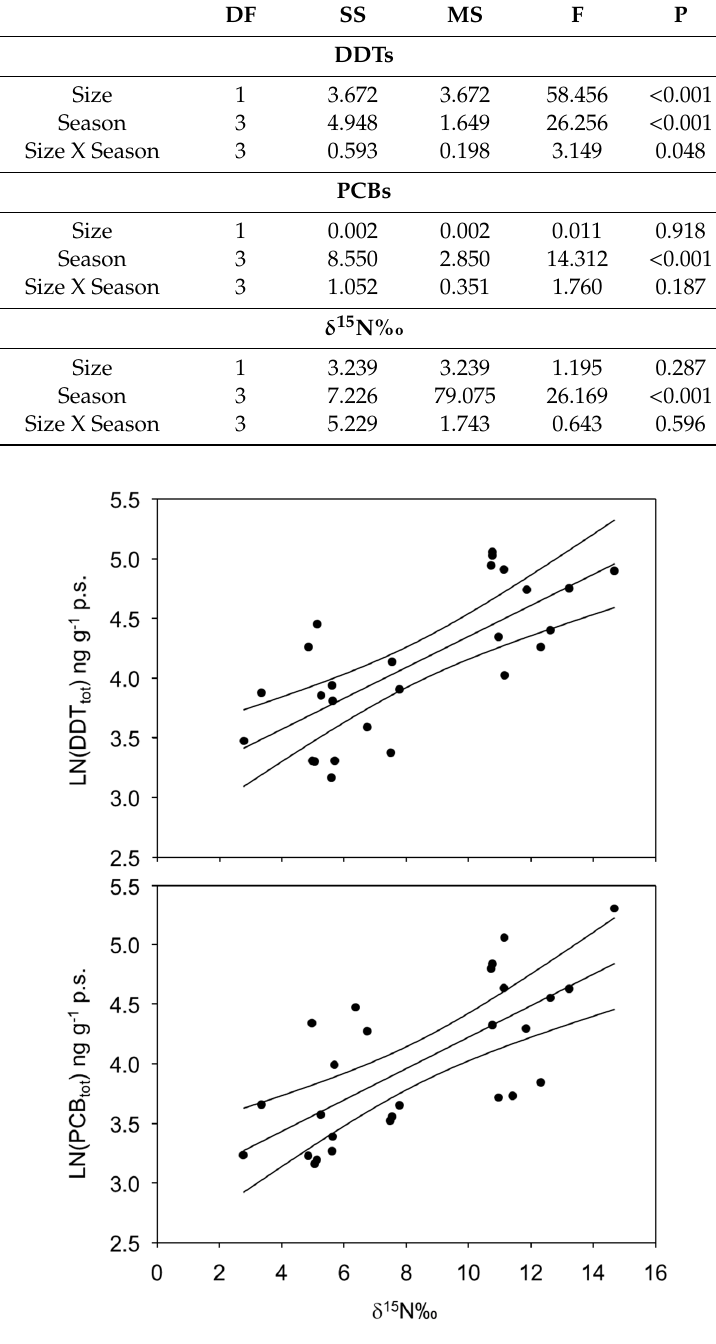
Figure 5. Relationship between nitrogen isotopic fingerprint of pooled zooplankton samples from Lake Maggiore, belonging to ≥ 450 µm and ≥ 850 µm size fractions, and persistent organic pollutant (POPs) concentrations, expressed as logarithmic